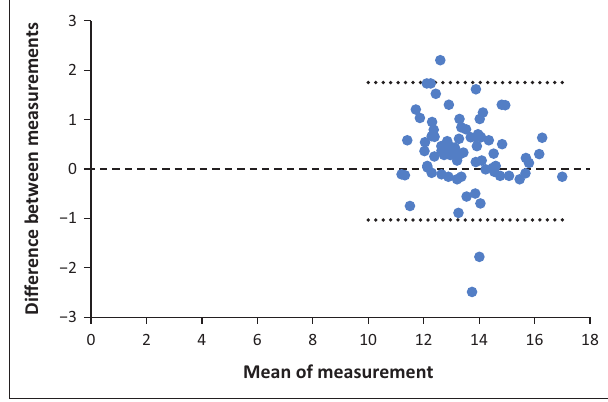
FIGURE 8: Agreement interval of the optic chiasm width.